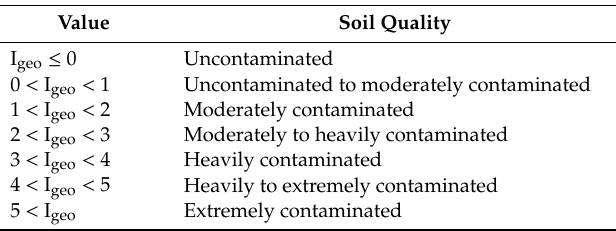
Table 2. Classification of the geo-accumulation